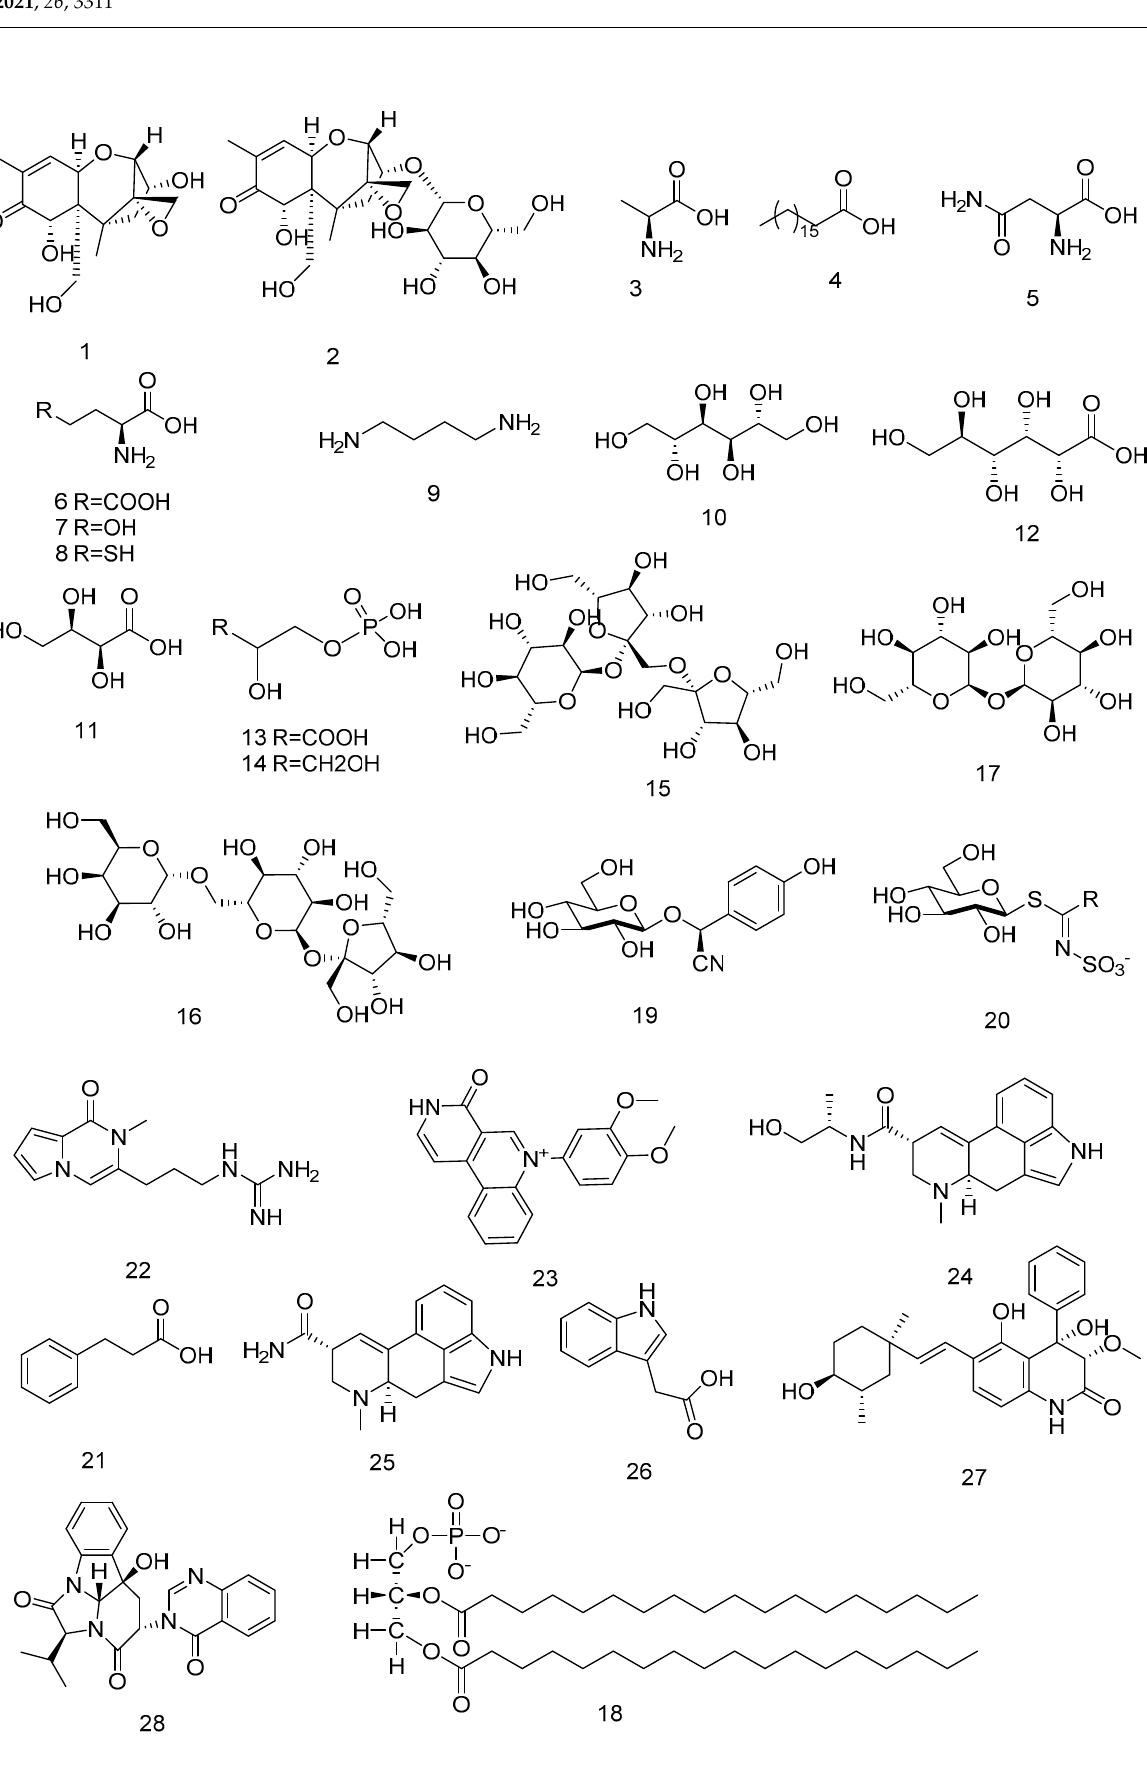
Figure 2. The structures of metabolites 1 – 28.